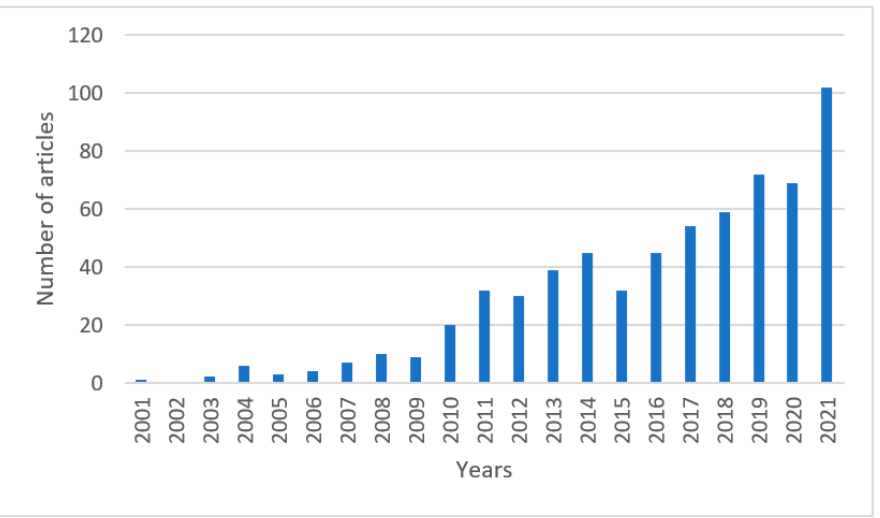
Figure 2. The increasing number of scientific papers devoted to the upgrading of biomass to hydrogen-rich gas (Scopus 27 September 2022, biomass + upgrading + hydrogen).